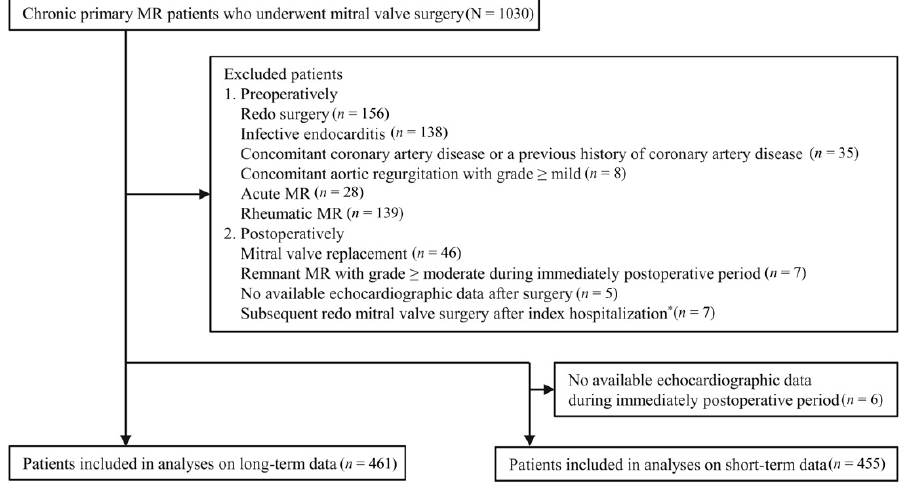
Figure 1. Flow diagram. MR, mitral regurgitation. * Included 1 patient with multiple echogenic masses in the mitral valve, 3 with severe MR development, 2 with significant MR development with hemolytic anemia, and 1 with infective endocarditis.